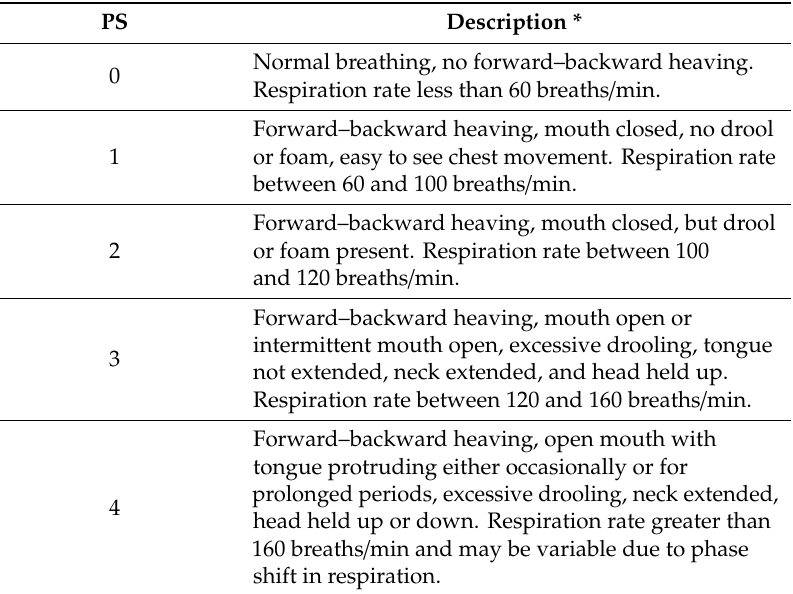
Table 3. The respiratory dynamic and panting score (PS) of cattle as modified from Gaughan et al. [25], Mader et al. [26], and Brown-Brandl et al.